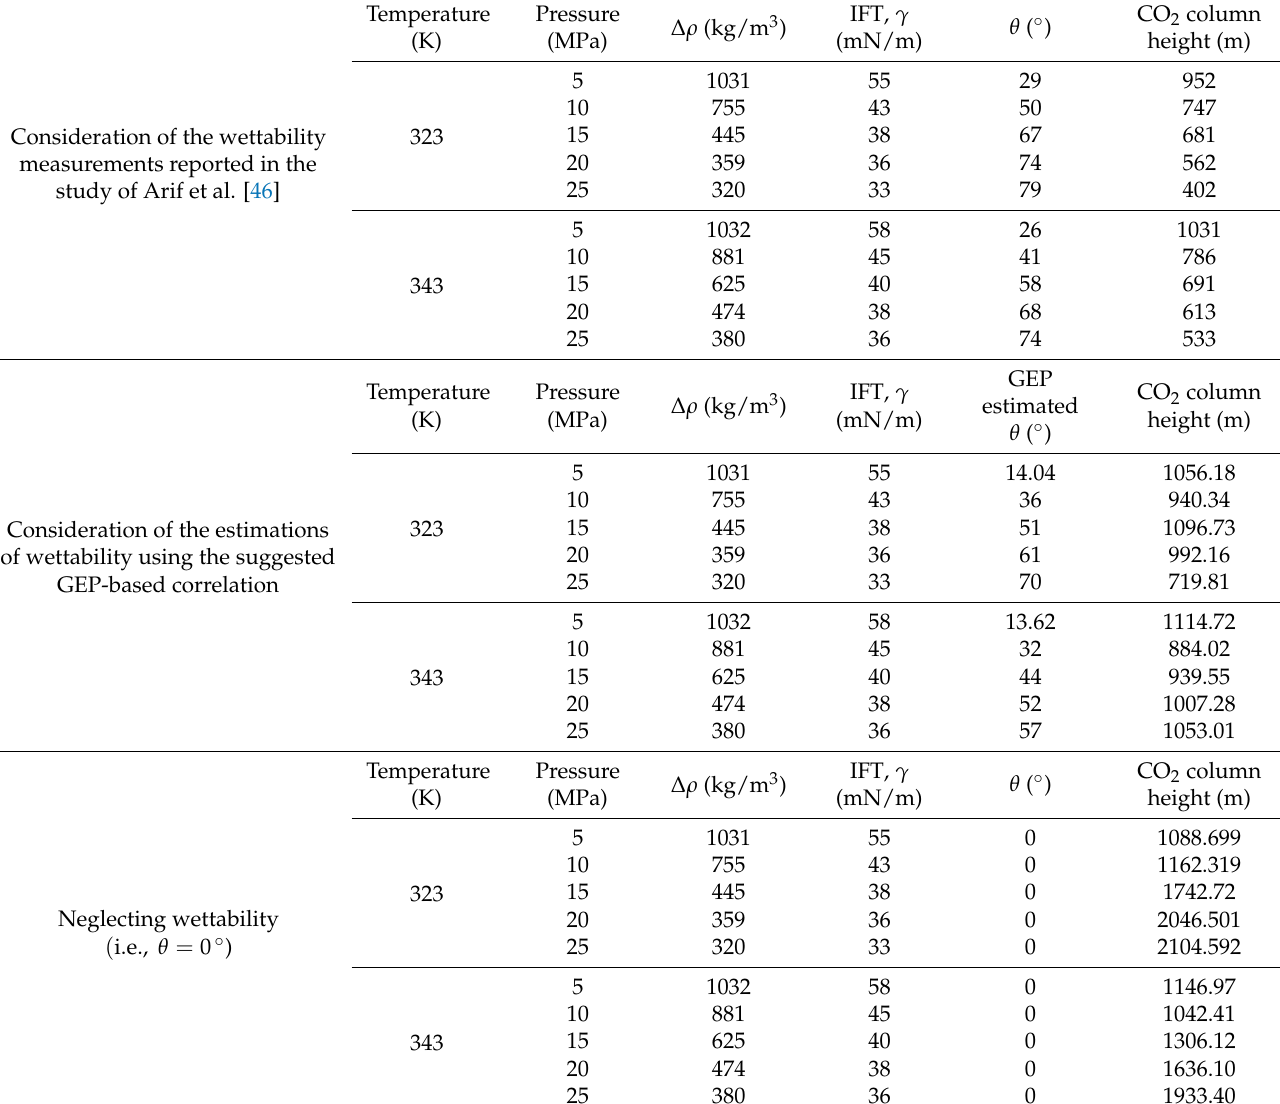
Table 5. Comparison between CO 2 column height values of the considered